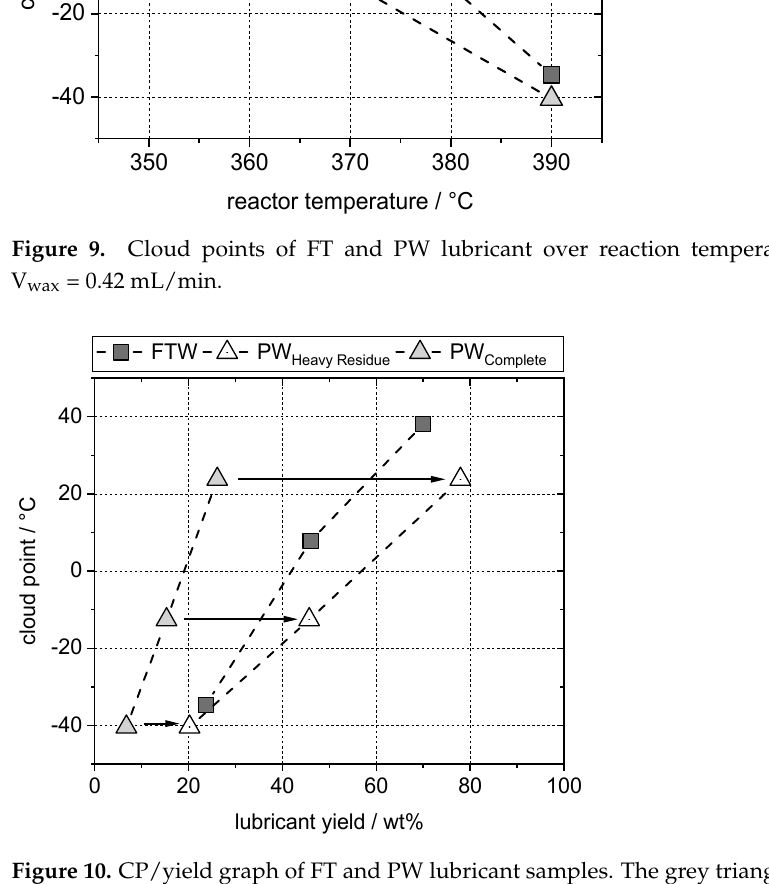
Figure 10. CP/yield graph of FT and PW lubricant samples. The grey triangles depict the de facto lubricant yield from pyrolysis wax, while the white triangles symbolize the yield in relation to the amount of heavy residue after the hydrogenation experiments (33.5 wt% in Hyd. 2).